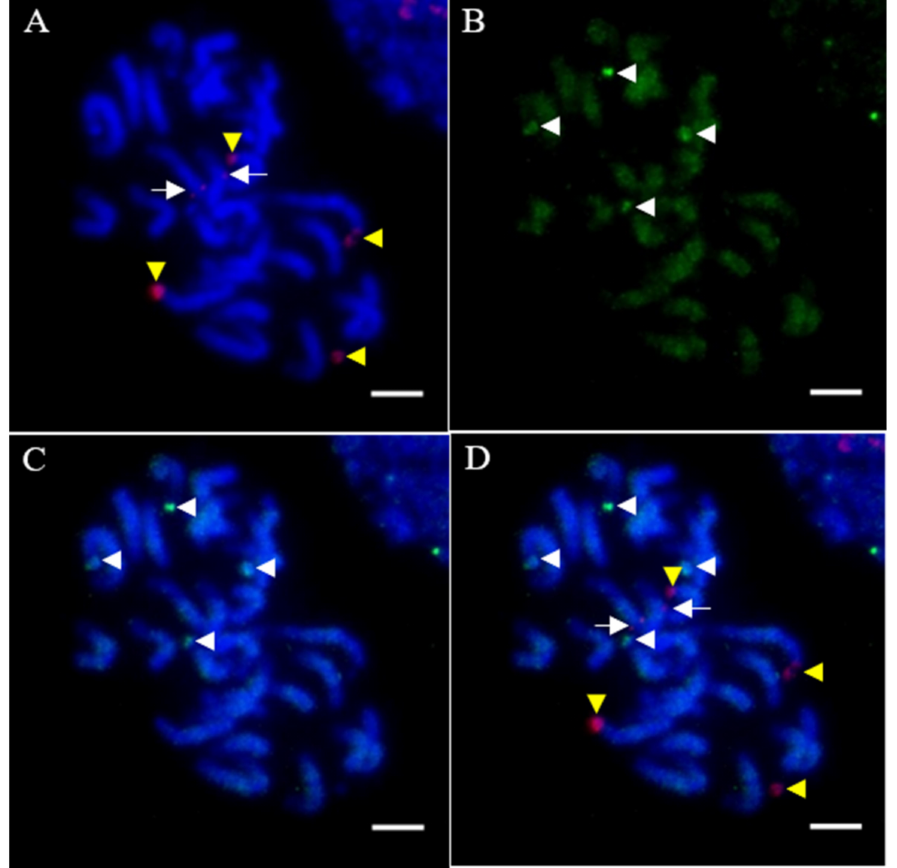
Figure 7. Localization of Ty1- copia 35S rDNA and 5S rDNA probes on root-tip mitosis prometaphase chromosomes of P. purpureum (2 n = 4 x = 28) by FISH. ( A ) Location of 35S rDNA and 5S rDNA on prometaphase chromosomes. ( B ) Location of Ty1- copia on prometaphase chromosomes. ( C ) The merged signals combined Ty1- copia and chromosomes (DAPI). ( D ) The merged signals combined Ty1- copia , 35S rDNA, 5S rDNA and chromosomes (DAPI). White arrows indicated Ty1- copia signals (green). Yellow arrows indicated 35S rDNA signals (red). Long white arrows indicated 5S rDNA signals (red). Scale bars = 5 µ